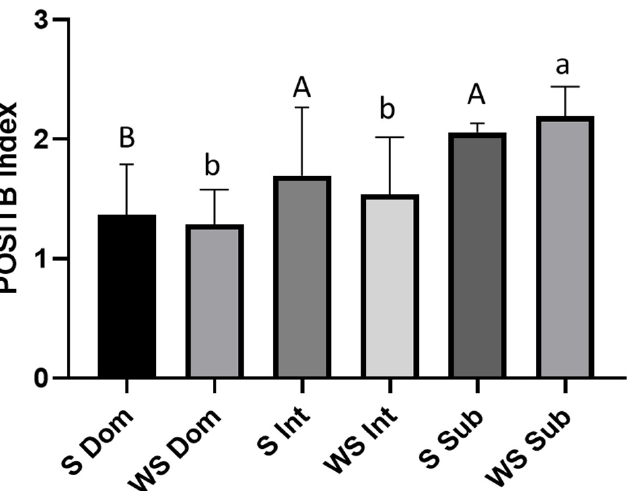
Figure 3. Positions before feeding (POSITB index) in Senegalese sole juveniles for dominant ( n = 6), intermediate ( n = 12) and subordinate fish ( n = 6) per environment. S = Sand; WS = Without Sand; Dom = dominant; Int = Intermediate; Sub = Subordinate. Data are shown as mean ± SD. Different letters indicate significant differences within the same environment (two-way ANOVA; p <